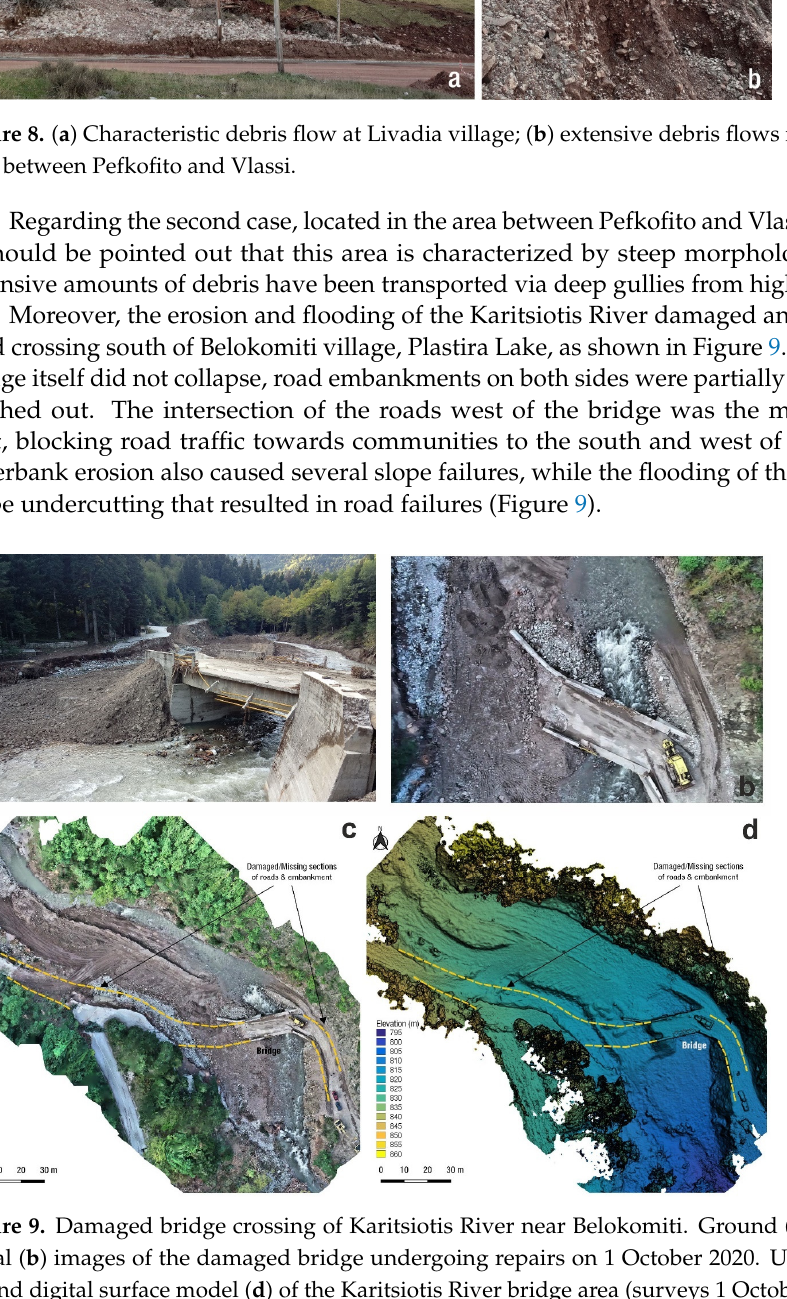
Figure 8. ( a ) Characteristic debris flow at Livadia village; ( b ) extensive debris flows in gullies in the area between Pefkofito and Vlassi.